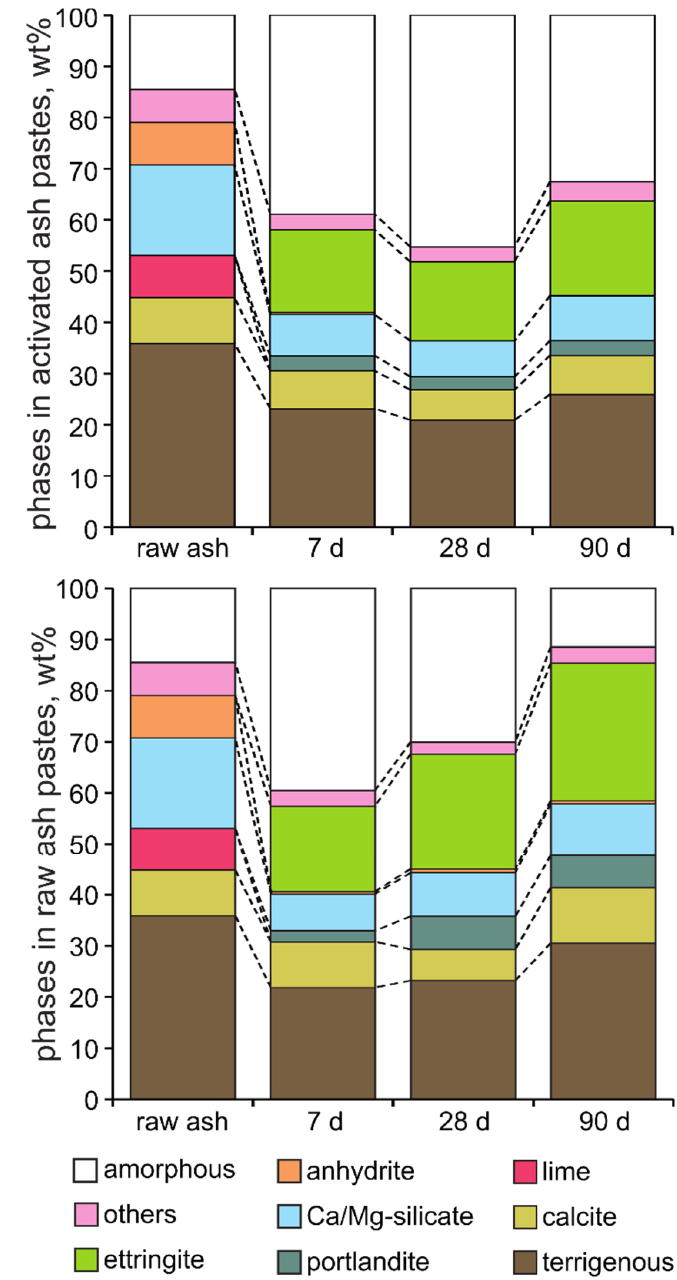
Figure 7. Mineralogical composition of raw ash and ash and water mixed raw ash and mechanically activated (4 min) pastes after 7, 28, and 90 days of curing. Terrigenous minerals—quartz, K-feldspar, mica/muscovite; calcite; lime; portlandite; Ca/Mg-silicate—C2S, merwinite, akermanite; ettringite; anhydrite; others—hematite, gypsum,